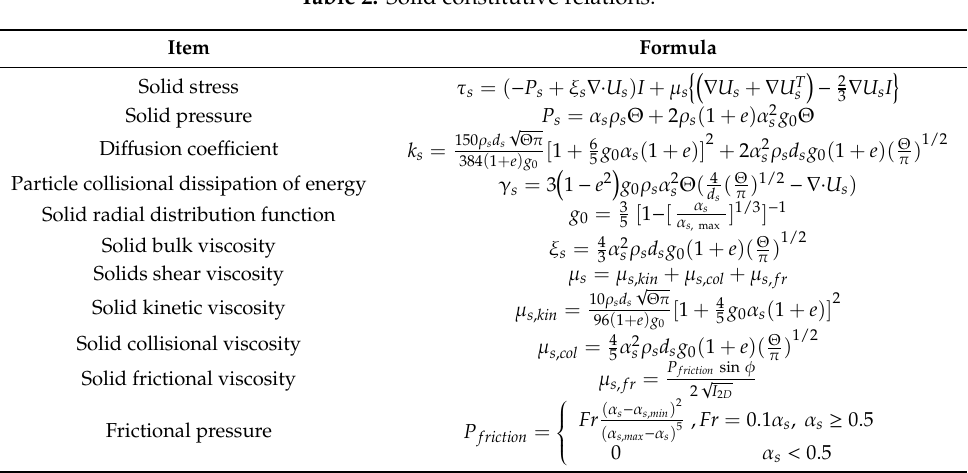
Table 2. Solid constitutive